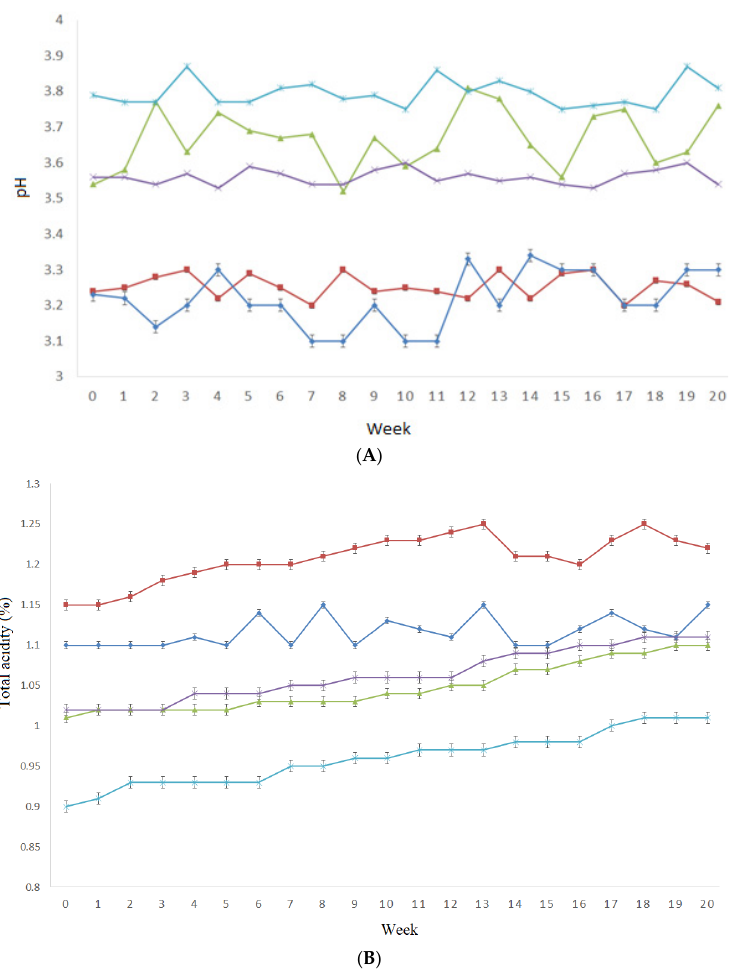
Figure 2. pH ( A ) and titratable acidity ( B ) of hot sauces prepared with tequila (dark blue line), bourbon (green line), vodka (purple line), rum (light blue line), and control (brown line) during 20 weeks of storage under accelerated